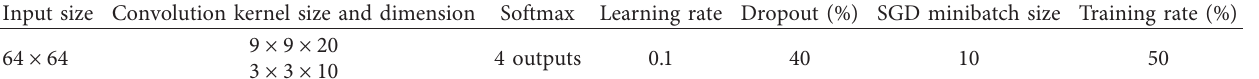
Figure 3: Structure of CNN. Table 1: Parameters of CNN.